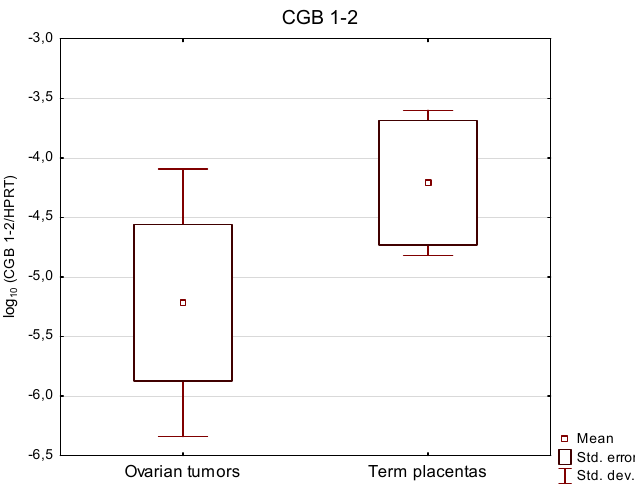
Figure 3. Relative expression of CGB1-2 genes in ovarian carcinomas and term placentas. None of studied healthy ovaries exhibited expression of CGB1-2 . Results are presented as the logarithm to the base